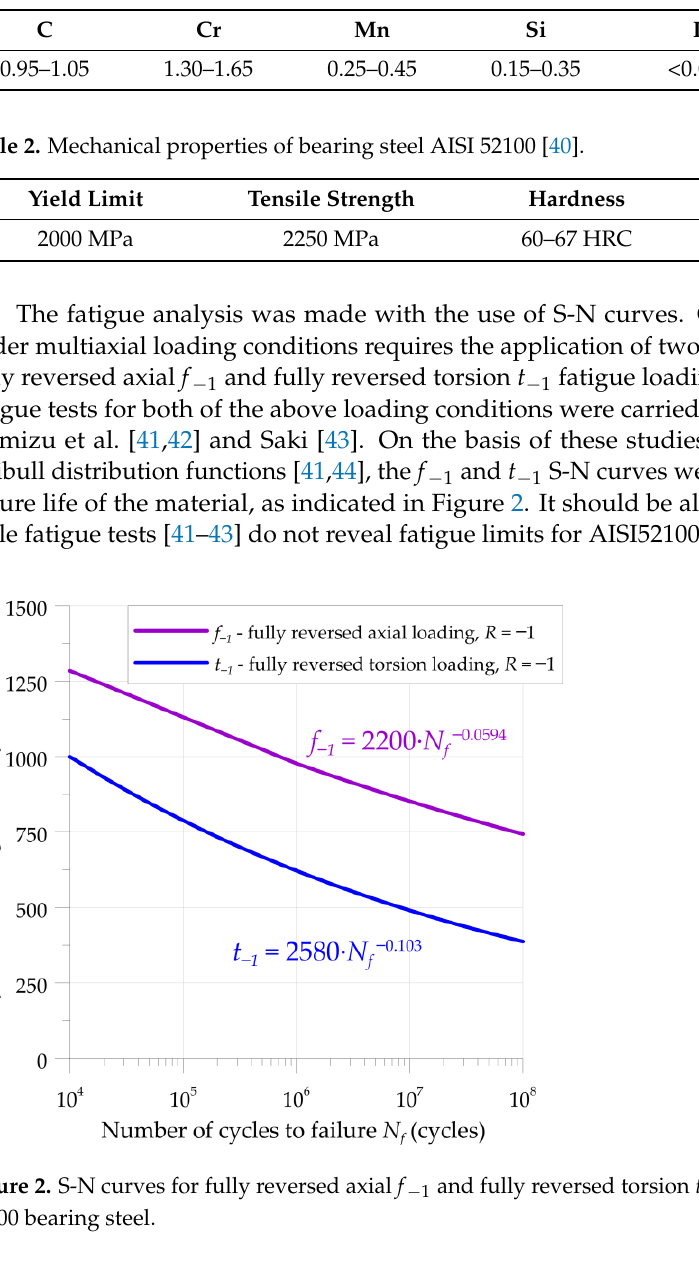
Figure 2. S-N curves for fully reversed axial f -1 and fully reversed torsion t -1 fatigue loadings, AISI 52100 bearing steel.